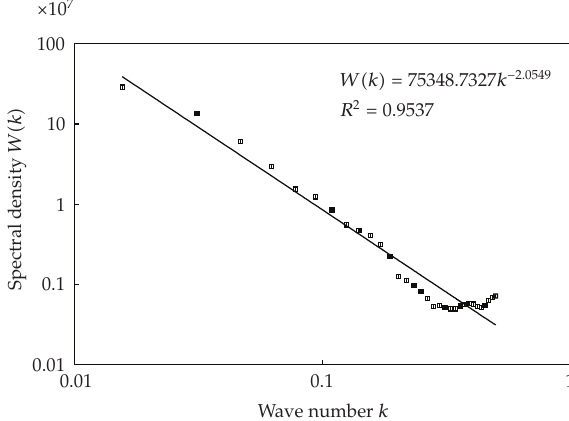
Figure 5: A log-log plot of the wave spectrum relation of Beijing’s population density (cid:3) 2000 (cid:4)